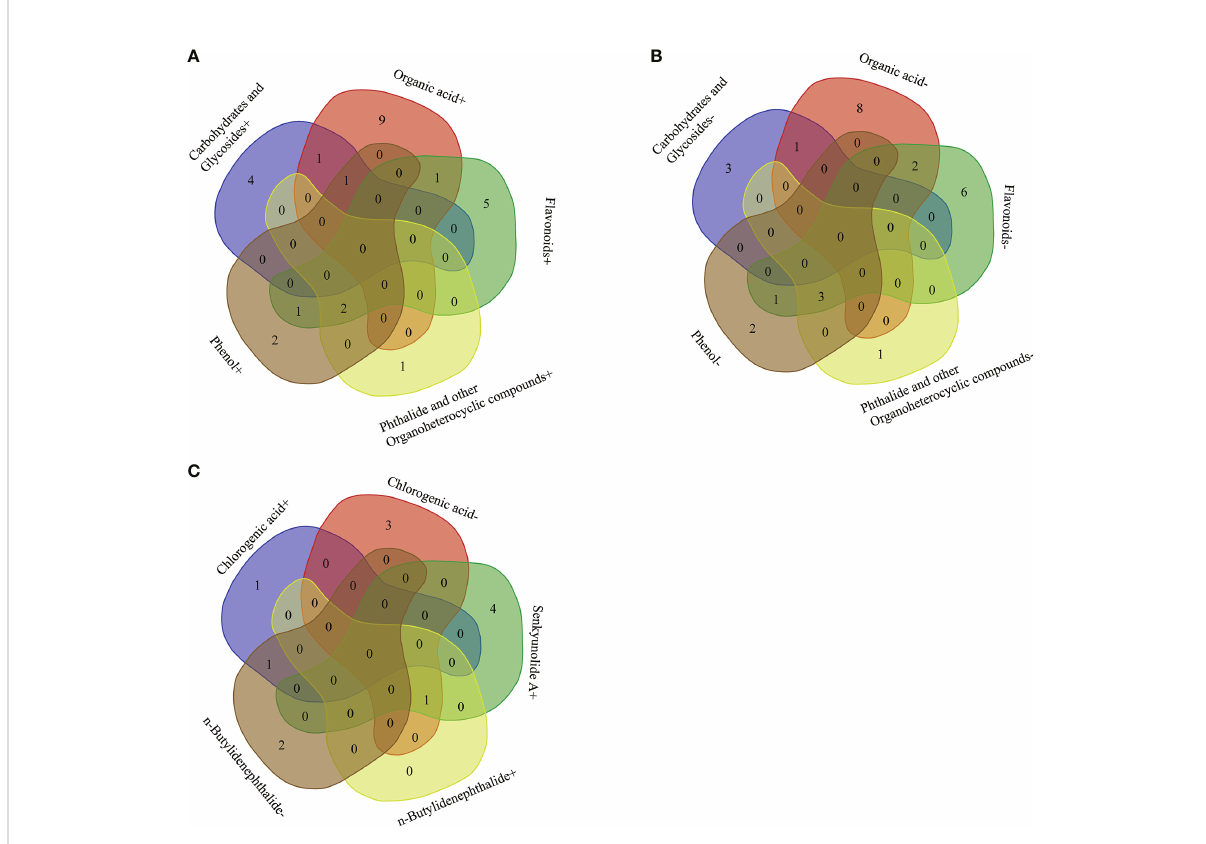
FIGURE 8 Venn comparative analysis of main differential secondary metabolites of A . sinensis and differential microbes correlated positively (A) . Venn comparative analysis of main differential secondary metabolites of A . sinensis and differential microbes correlated negatively (B) . Venn comparative analysis of the correlation between differential medicinal components of A . sinensis and differential microbes (C)